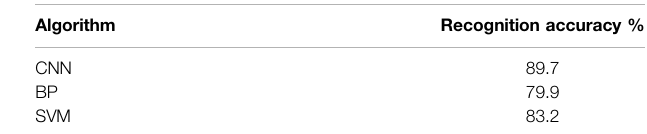
TABLE 3 | Recognition results under different recognition